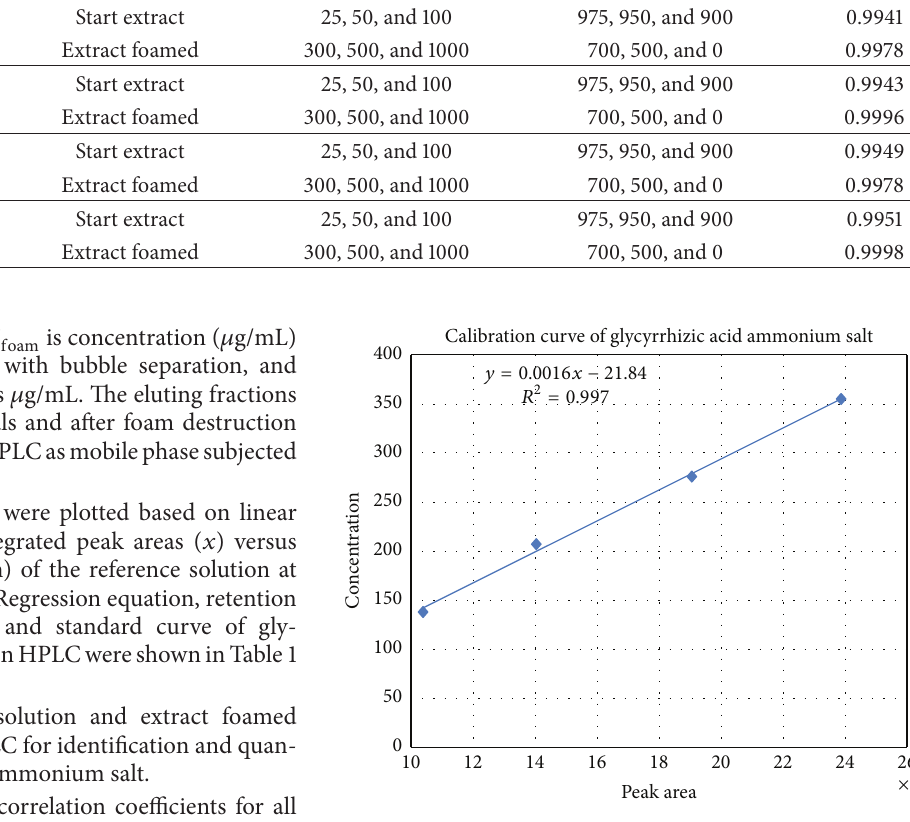
Figure 2: Standard curve of reference compounds on